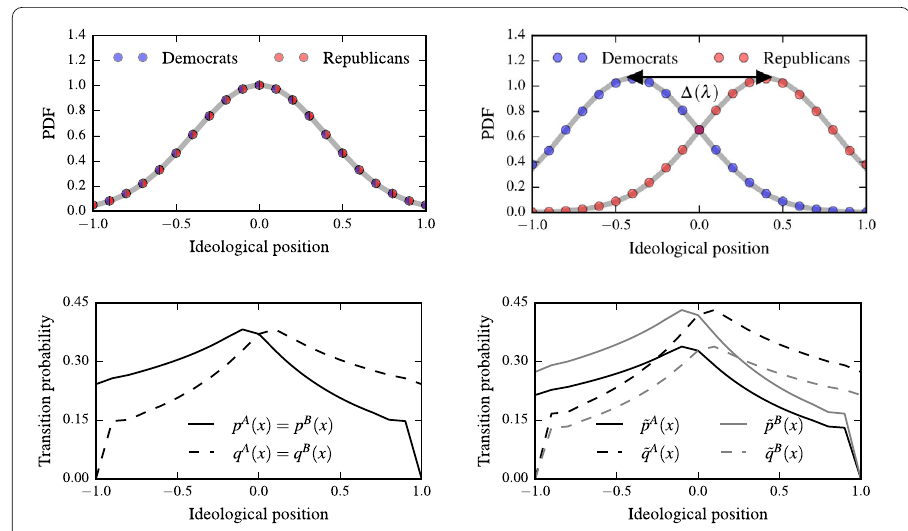
Figure 3 The emergence of political polarization. The top panels show an unpolarized (left panel) and a polarized (right panel) ideology distribution (synthetic/simulation data only). Democrats are represented by blue disks and Republicans by red disks. We use (cid:3) ( λ ) to denote the absolute value of the difference between the shifts in the mean ideologies. The bottom panels show the corresponding transition probabilities which define the ideology distribution according to Eqs. (6) and (7) with N = 21 states. We rescaled the probabilities in the right panel according to Eqs. (10) and (11) by setting λ = λ A = λ B =